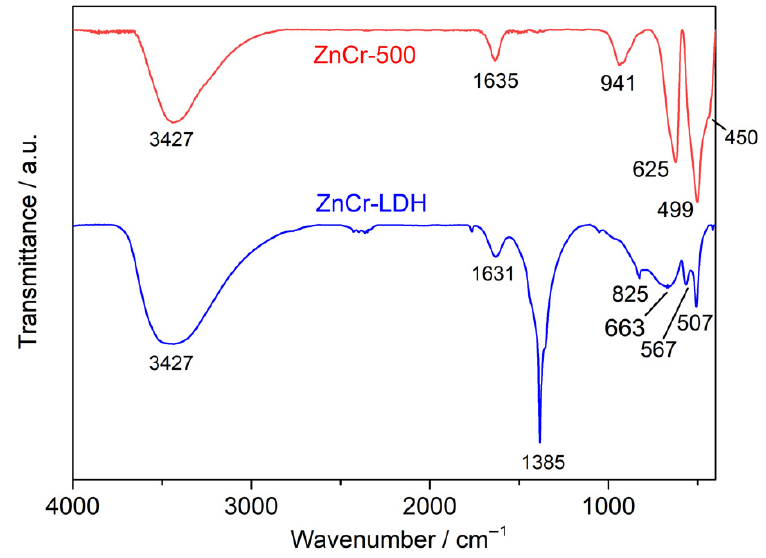
Figure 2. FTIR spectrum of ZnCr-LDH and ZnCr-500 photocatalysts.